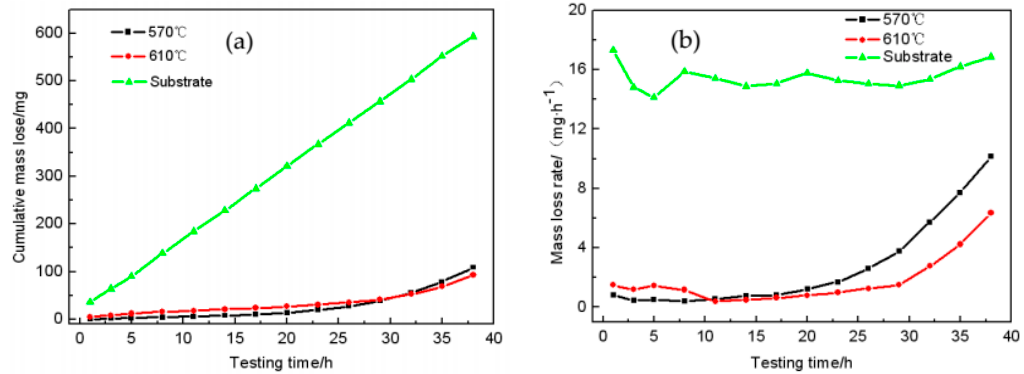
Figure 6. Mass loss and rate curves of the substrate and two samples: ( a ) cumulative mass loss curve; ( b ) mass loss rate curve.